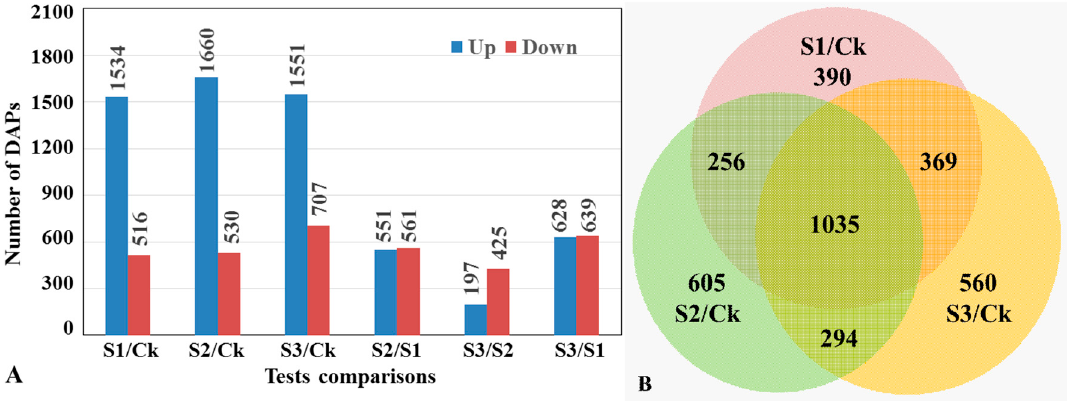
Figure 1. Number of differentially accumulated proteins (DAPs) in wheat infected by stripe rust. ( A ). Bar chart. The blue and red bars represent up- and down-regulated DAPs, respectively. The numbers of test comparisons are shown above each bar. S1, S2, and S3 represents the samples of Pst -inoculated at 24, 48, and 72 hpi, while Ck means the mock-inoculated sample. ( B ). Venn diagram. The number of specific and overlapped DAPs between timepoints were given.